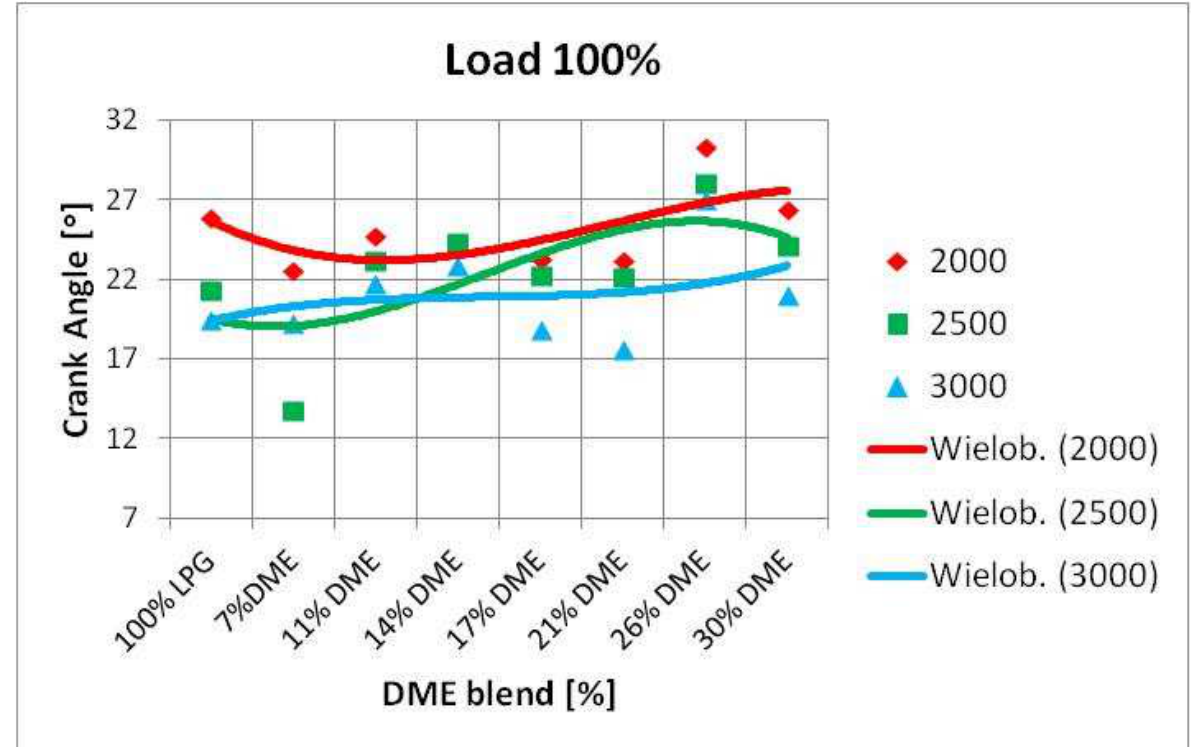
Figure 11. Change of maximum in-cylinder pressure angle vs. crank angle correction.